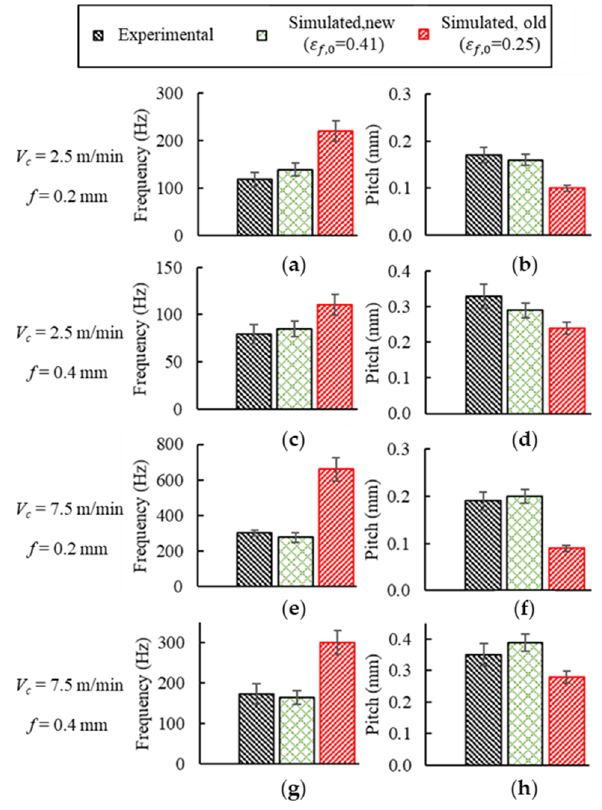
Figure 20. Frequency ( a,c,e,g ) and pitch ( b,d,f,h ) predictions, comparing the reference and the optimized law.